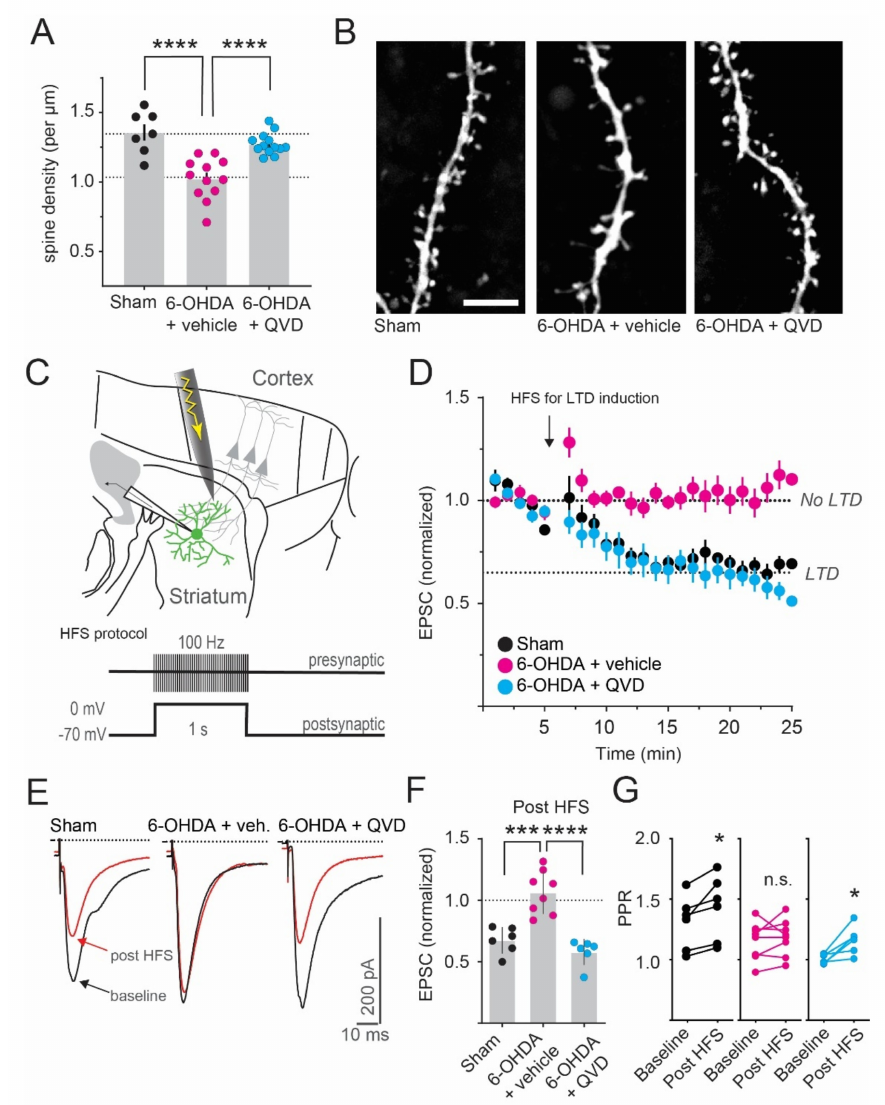
Figure 3. Early synaptic deficits after DA denervation are prevented by pharmacological caspase inhibition. ( A ) Dendritic spine density of iSPNs is reduced 5–6 days post-6-OHDA lesion. This loss is prevented by systemic treatment with the caspase inhibitor Q-VD-OPh (“QVD”). **** p < 0.0001 vs. 6-OHDA + vehicle, ANOVA and post hoc Bonferroni tests. N = 7–13 cells. ( B ) Two-photon images of iSPN dendrites, visualized after dye-filling the neurons through the patch pipette. Maximum- intensity projections of dendrites from controls and 6-OHDA-lesioned mice treated with vehicle or QVD are shown from left to right. Scale bar: 5 µ m. ( C ) Sketch of the LTD recording paradigm. GFP-positive iSPNs were patched in the dorsolateral striatum and the stimulus electrode was placed near the border of the cortex. To induce LTD, high-frequent input stimulation (1 s at 100 Hz) was paired with postsynaptic depolarization. ( D ) Corticostriatal EPSCs are depressed using this protocol in control iSPNs (black). However, EPSC amplitudes are unchanged after HFS in 6-OHDA lesioned mice at 5–6 days after lesion (magenta). Co-treatment with QVD rescues this deficit, and LTD is readily induced (cyan). ( E ) Example traces from the recordings. Single EPSCs are shown before (black) and after (red) HFS. ( F ) Quantification shows loss and rescue of HFS-LTD. *** p < 0.001, **** p < 0.0001 vs. 6-OHDA + vehicle, ANOVA and post hoc Bonferroni test, N = 6-8 cells ( G ) After HFS-LTD induction, paired-pulse ratios (PPRs) are increased in control iSPNs (black) and unchanged in the DA-denervated striatum (magenta). Treatment with QVD rescues the LTD induction, with concomitant increase in PPRs (cyan). * p < 0.05, paired t -test, N = 6-8